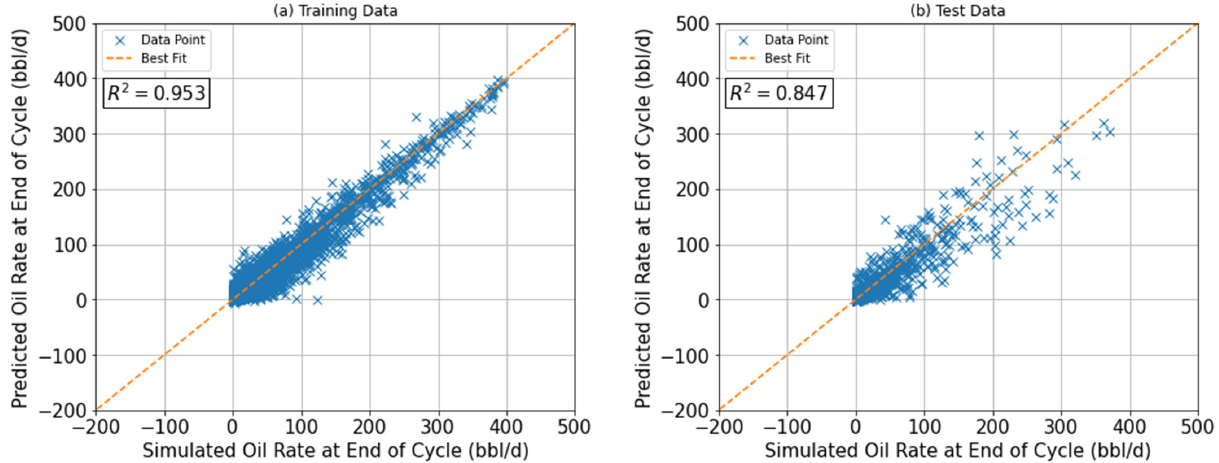
Figure 10. Predicted and simulated plot of ( a ) training data and ( b ) testing data for oil rate at the end of the cycle—neural network model.